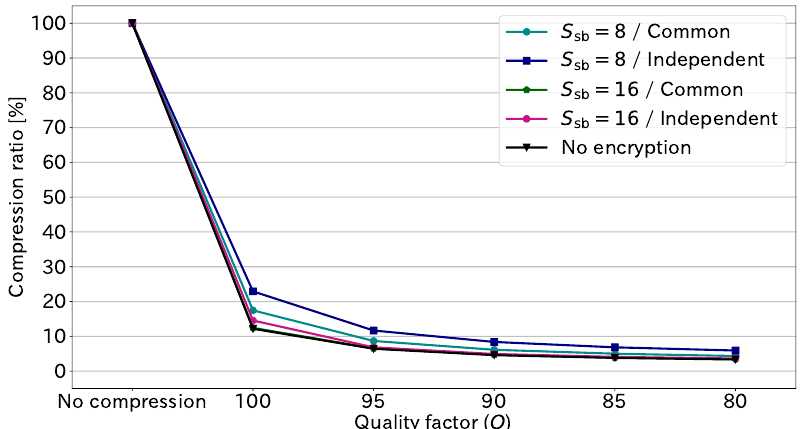
Figure 10. Compression ratio at each quality